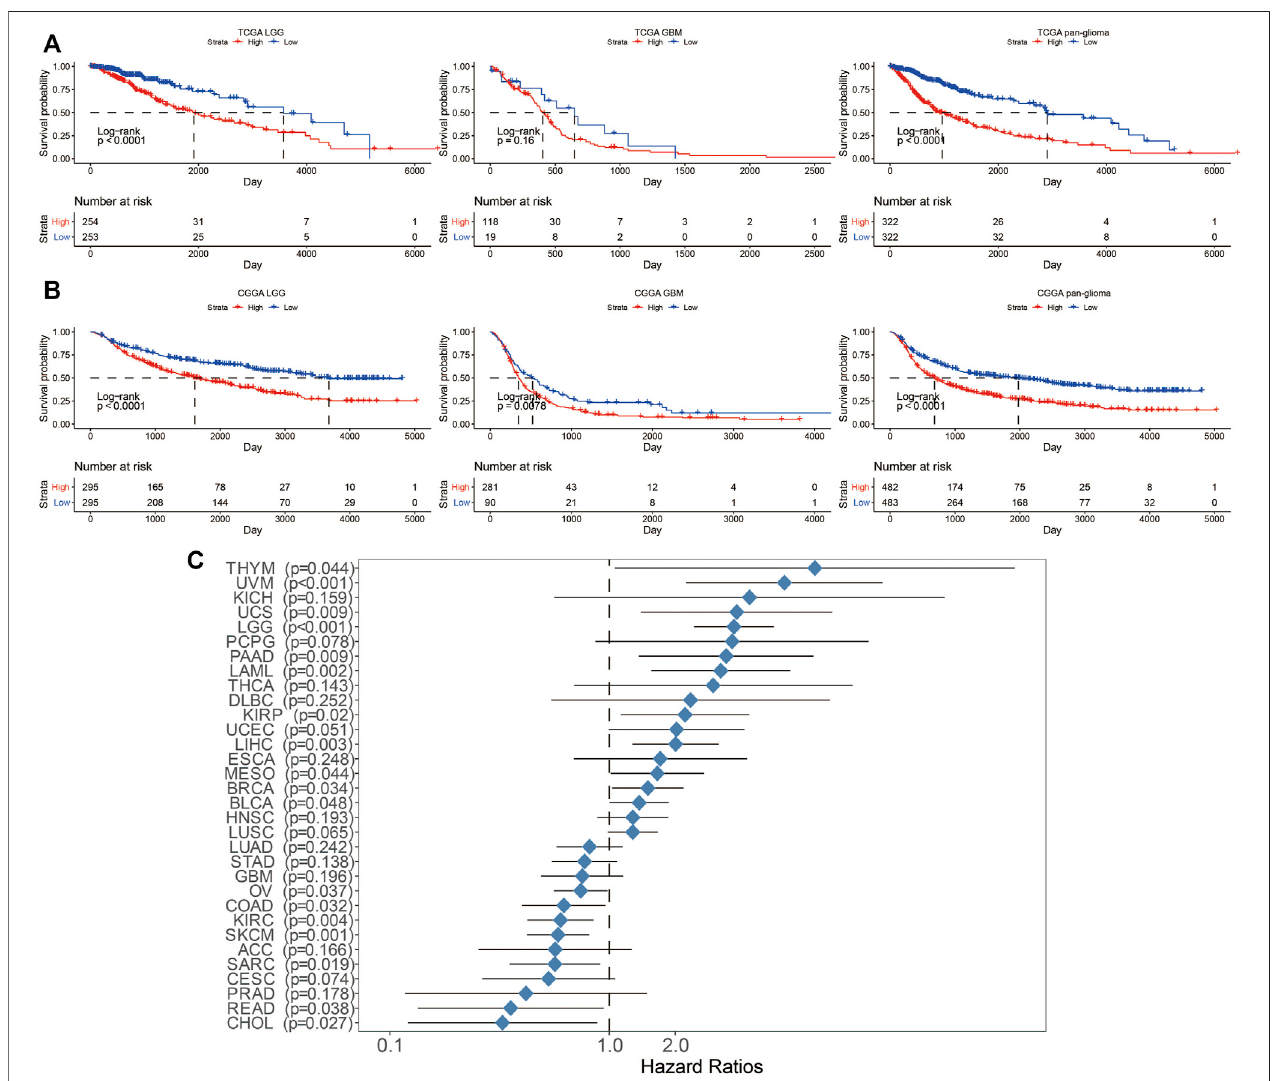
FIGURE 2 | Survival analysis in glioma patients with different levels of LYN expression. Kaplan – Meier curve of OS in glioma samples in (A) . TCGA and (B) . CGGA. p -valueswerecalculatedbasedonlog-ranktest (C) .UnivariatecoxregressionanalysisevaluatingprognosticvalueofLYNexpressionindifferentcancertypesregarding OS in TCGA. The length of horizontal line represents the 95% con fi dence interval. The vertical dotted line represents the HR of cancer patients. HR < 1.0 indicates that high LYN expression is a favorable prognostic biomarker.